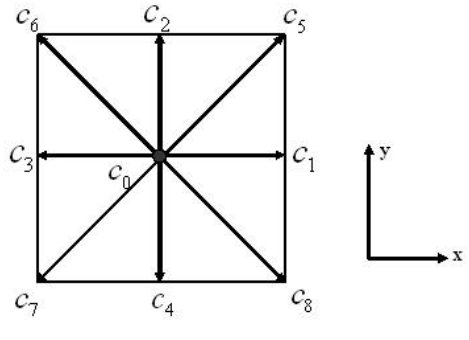
Fig.1 The discrete velocity for D2Q9